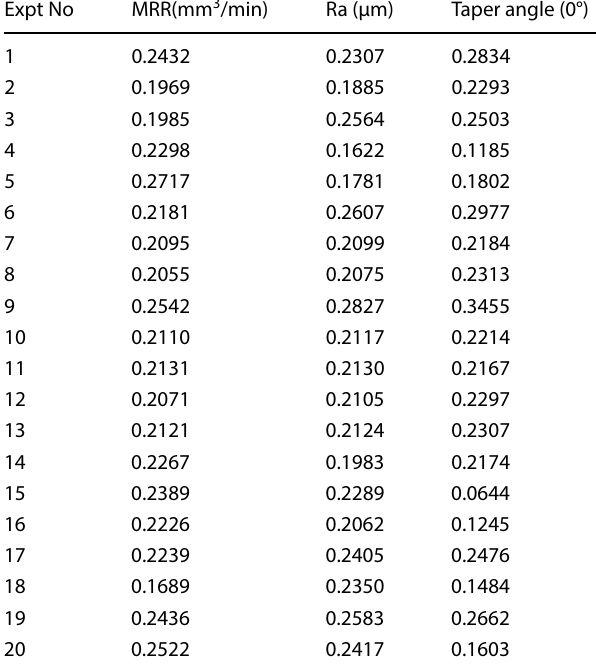
Table 8 Normalized decision matrix